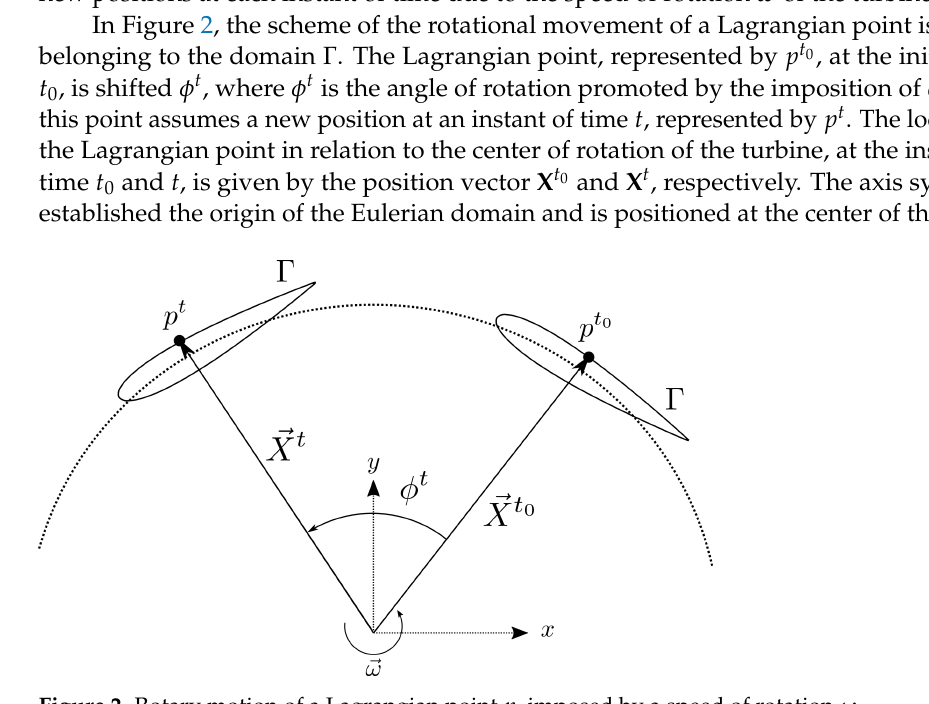
Figure 2. Rotary motion of a Lagrangian point p , imposed by a speed of rotation ω